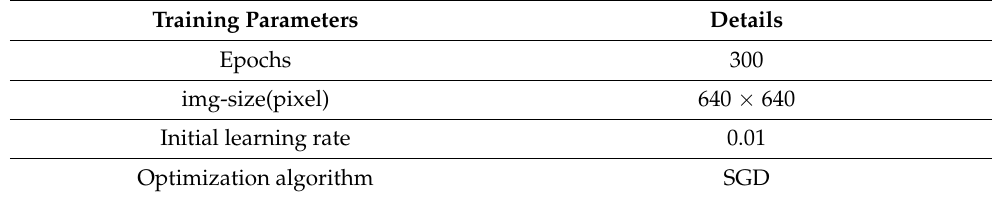
Table 4. The main training